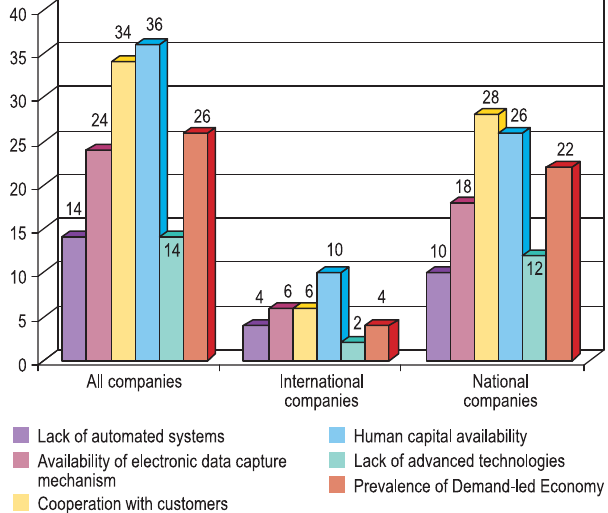
Fig. 1 . Institutional issues restricting CRM implementation Fig. 2. Infrastructure issues restricting CRM